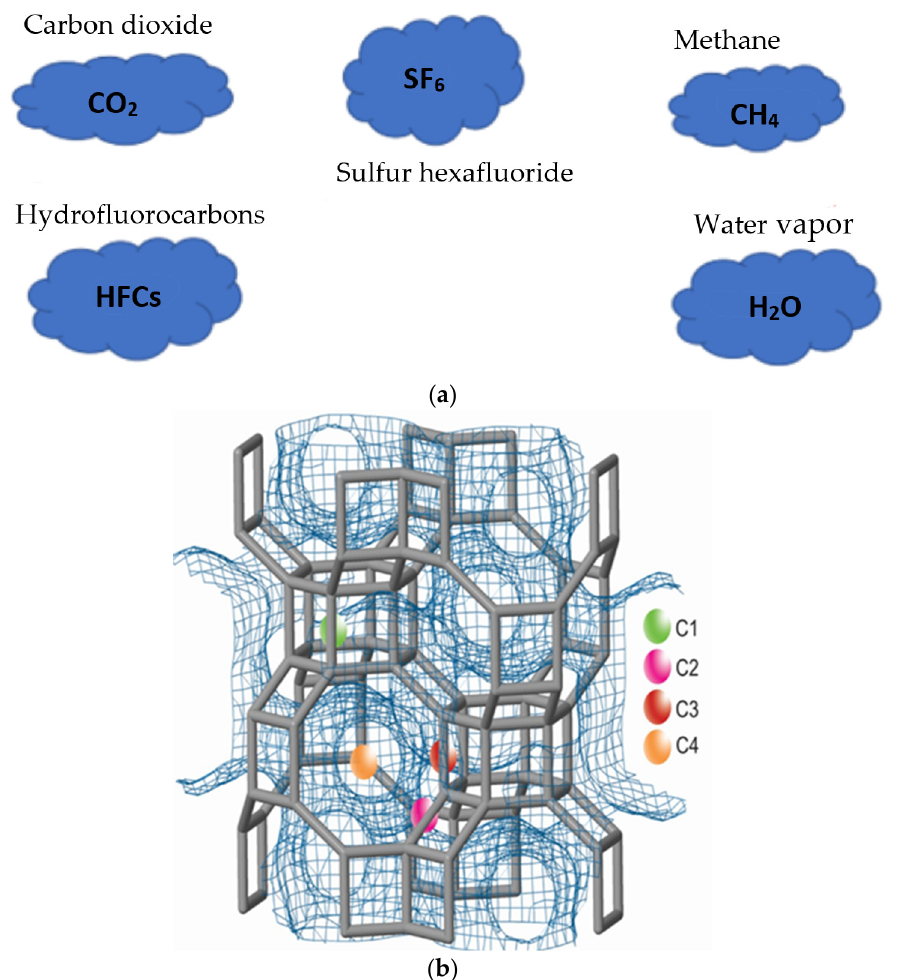
Figure 1. ( a ) Main greenhouse gases causing global warming. ( b ) Cationic chabazite positions: C1, D6R, C2, 8MR, C3, D6R and C4, 8MR.